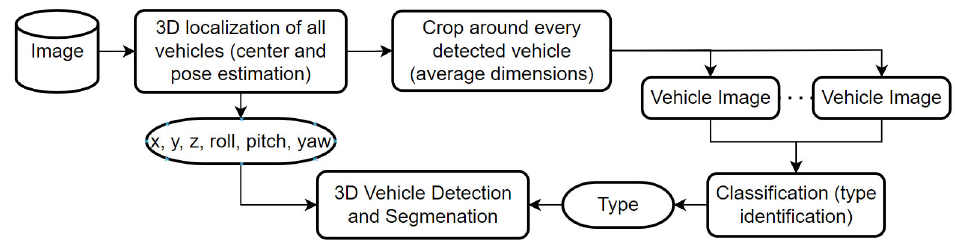
Figure 1. The proposed system